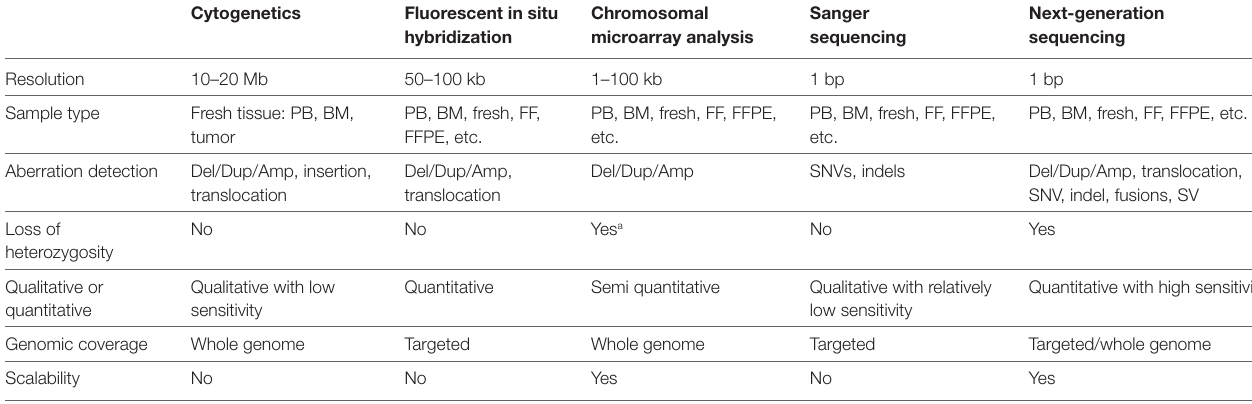
tAbLe 1 | Comparison of genomic technologies commonly used in clinical laboratories for leukemia